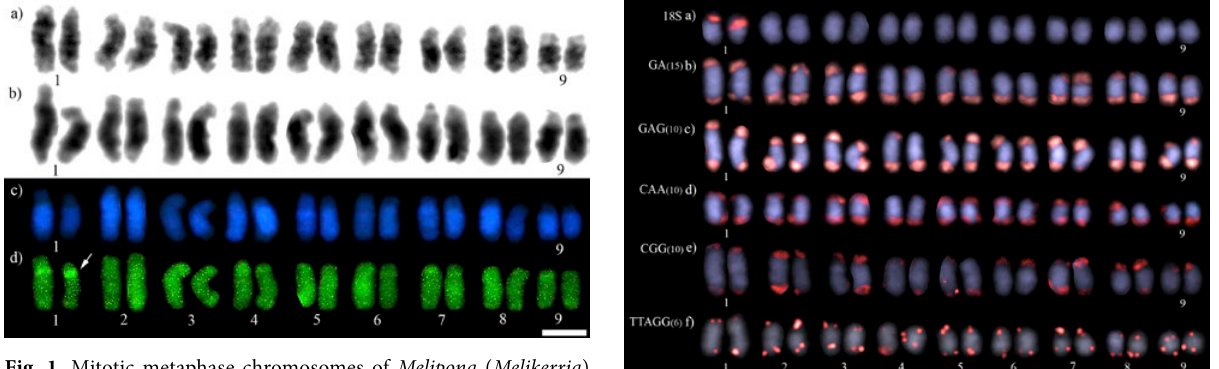
Fig. 1. Mitotic metaphase chromosomes of Melipona ( Melikerria ) interrupta stained with Giemsa (a), C- banding (b), DAPI (c), and CMA 3 (d). Scale bar = 5 μm. Fig. 2. Patterns obtained in metaphase chromosomes of Melipona ( Melikerria ) interrupta with FISH using the following repetitive DNA probes: 18S (a), GA (15) (b), GAG (15) (c), CAA (10) (d), CGG (10) (e), and TTAGG (6) (f). In blue: chromosomes stained with DAPI. In red: regions hybridized with probes. Scale bar = 5